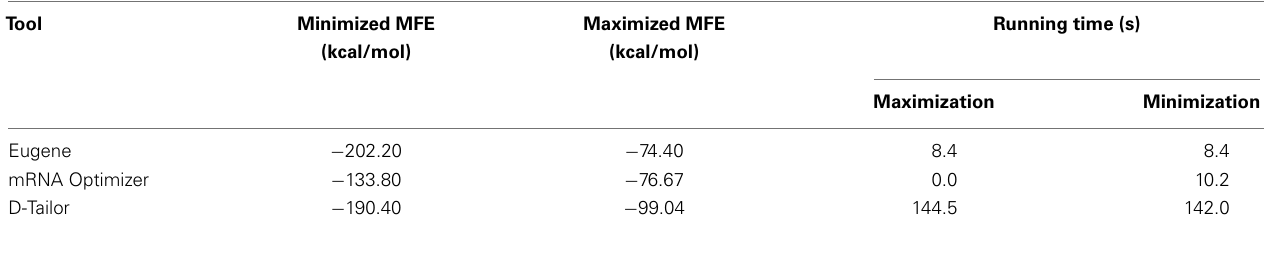
Table 4 | MFE optimization experiments of GFP mRNA